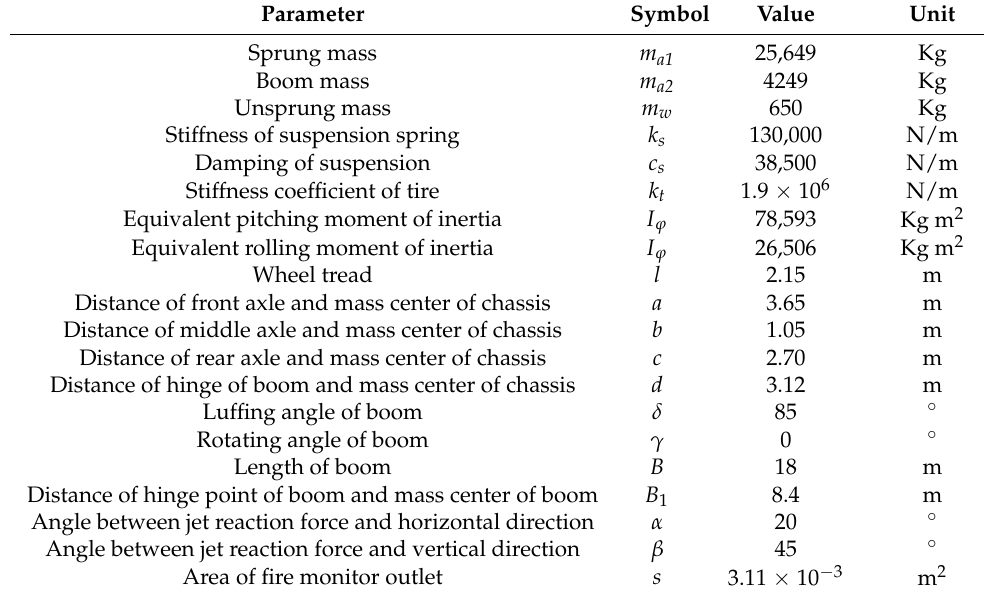
Table 1. Main parameters of the vehicle.